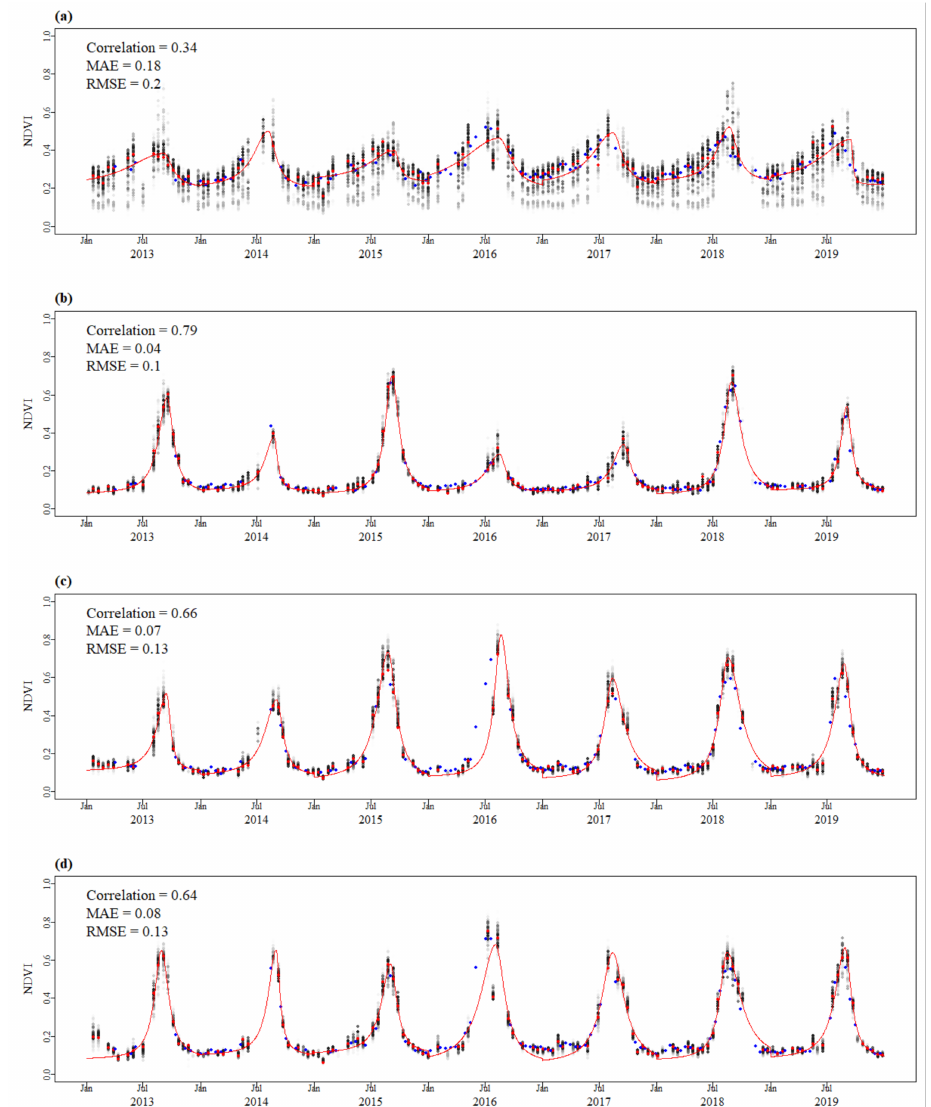
Figure 7. Fitted growth curves and test accuracy statistics for cells at four locations: ( a ) remnant vegetation, longitude 118.127, latitude − 31.266; ( b ) cropland, longitude 118.123, latitude − 31.248; ( c ) cropland, longitude 118.181, latitude − 31.277 and ( d ) cropland, longitude 118.142, latitude − 31.296. The Landsat-7 training data used to estimate the growth curves are shown in shades of grey according to their spatial weight (white lowest and black highest). Landsat-7 data for the cell are shown in red, and Landsat-8 test data are shown in